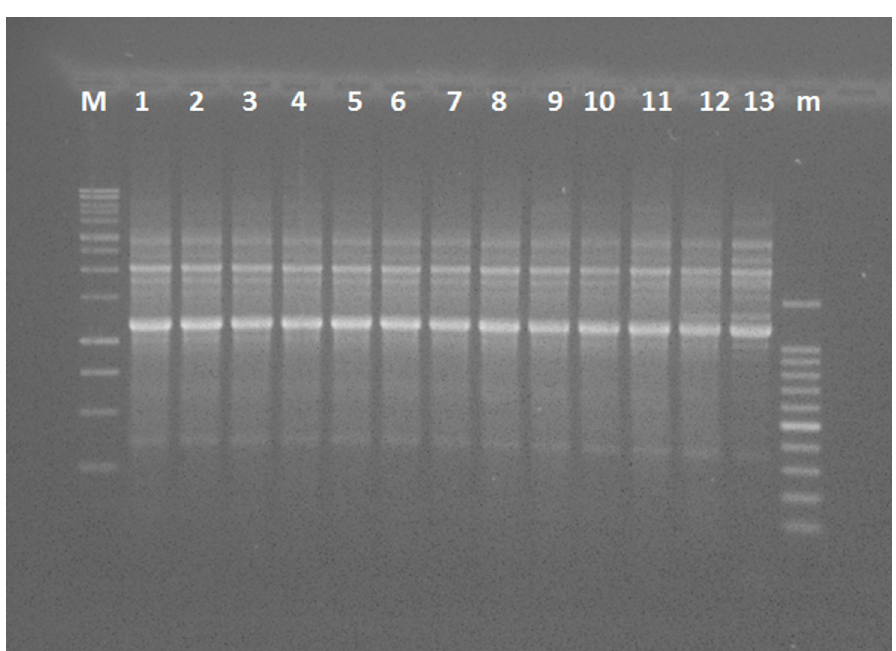
Fig 4. An example of BOX PCR fingerprint patterns obtained for genomic DNAs of Pseudomonas avellanae strains isolated from Corylus avellana by using the BOX primer set. Lanes from left to right — M: molecular size marker (1-kb ladder), 1: strain PaVT1, 2: strain PaVT2, 3: strain PaVT5, 4: strain PaVT6, 5: strain PaVT8, 6: strain PaVT10, 7: strain PaVT17, 8: strain PaVT24, 9: strain PaVT25, 10: strain PaVT28, 11: strain PaVT29, 12: strain NCPPB 3489, 13: strain NCPPB 3487 and m: molecular size marker (100bp ladder). All strains isolated in this study were clonal and no diversity was observed among them.